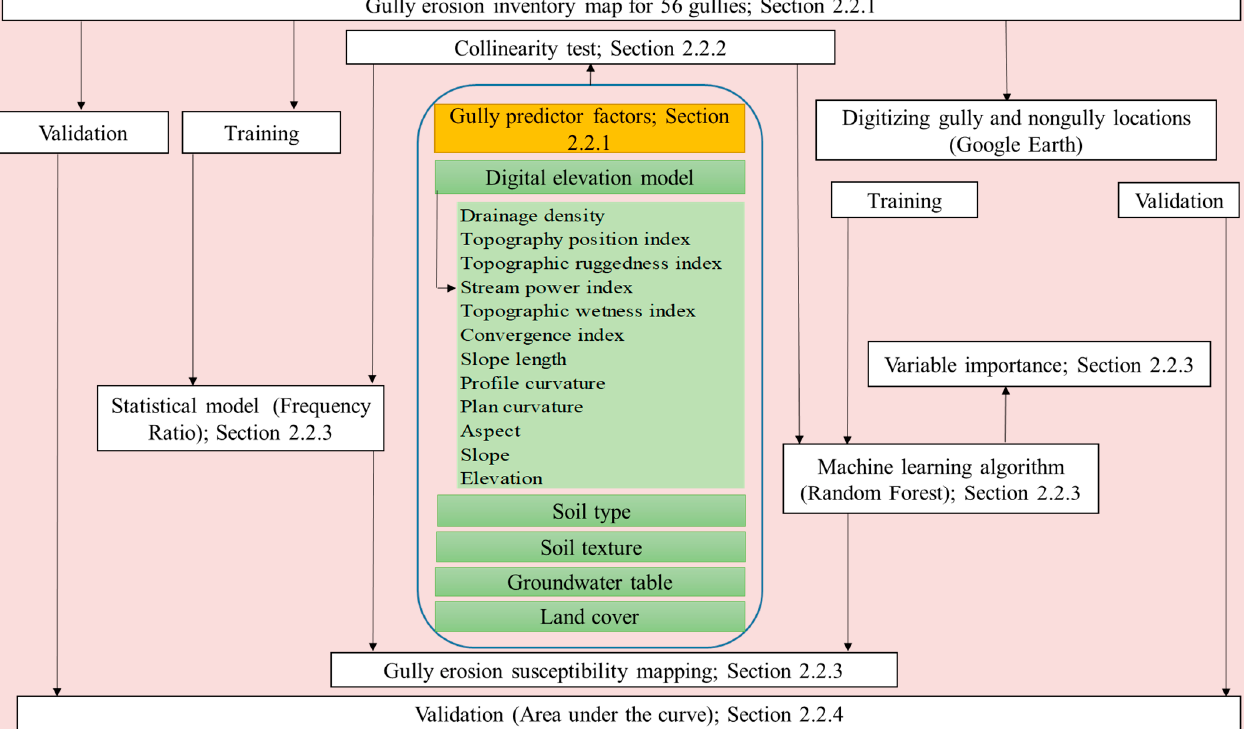
Figure 2. Research methodology flowchart.